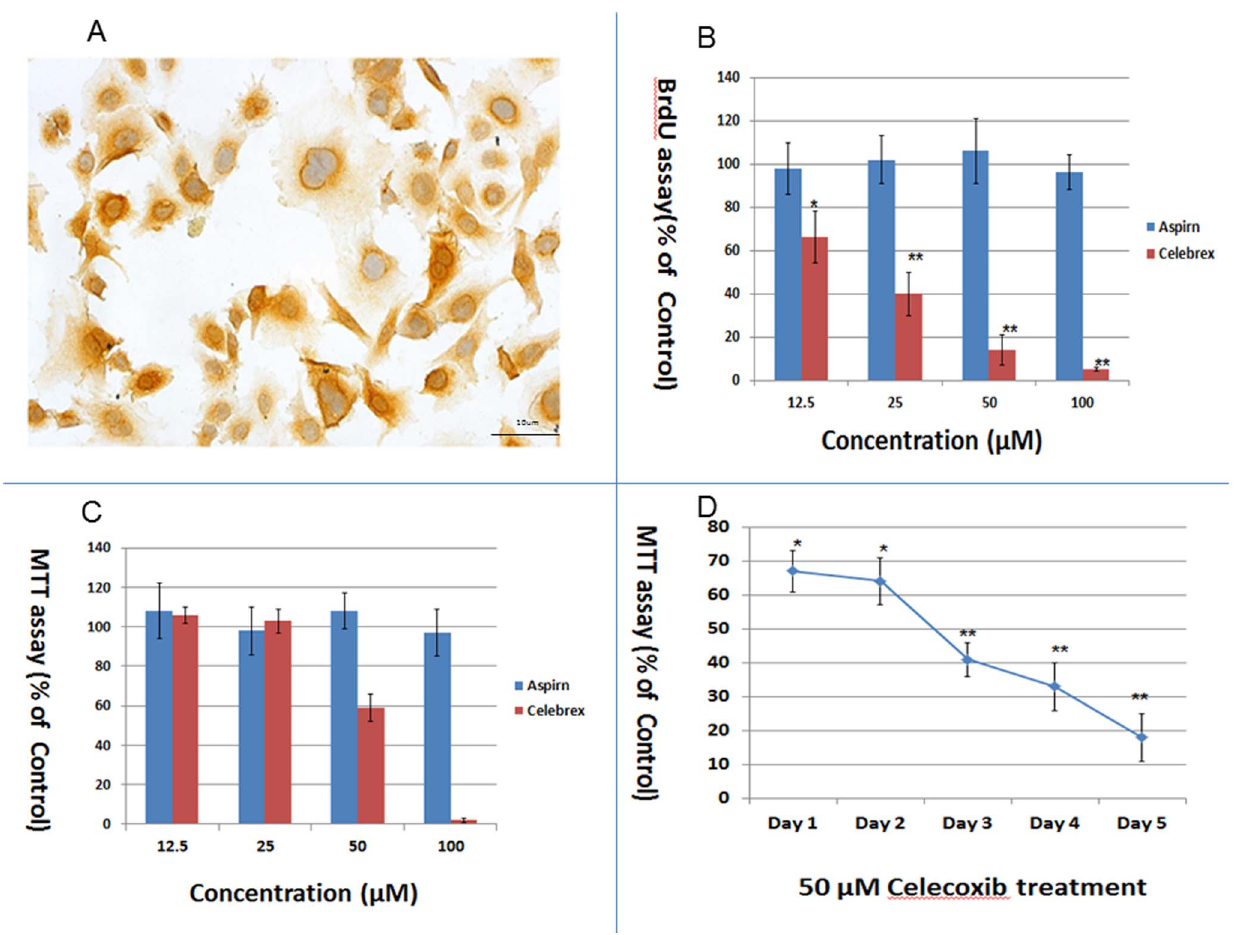
Figure 1. Celecoxib induced a potent anti-proliferative effect on CGCCA cells. (A) CGCCA cells with strong positive cytoplasmic immunoreactivity for COX-2 (400X). (B) Concentration-dependent anti-proliferative effect of celecoxib on CGCCA cells. CGCCA cells were incubated with various concentrations (12.5, 25, 50, and 100 m M) of celecoxib for 24 h. Cell proliferation was determined using the BrdU assay. (C) After 3 days of celecoxib treatment, cell viability was measured by the MTT assay. (D) Celecoxib (50 m M) induced growth repression in CGCCA cells in a time- dependent manner. Results are presented as % of the control. Each value is the mean 6 SD of 3 to 5 determinations. *p , 0.05, **p , 0.001 (versus